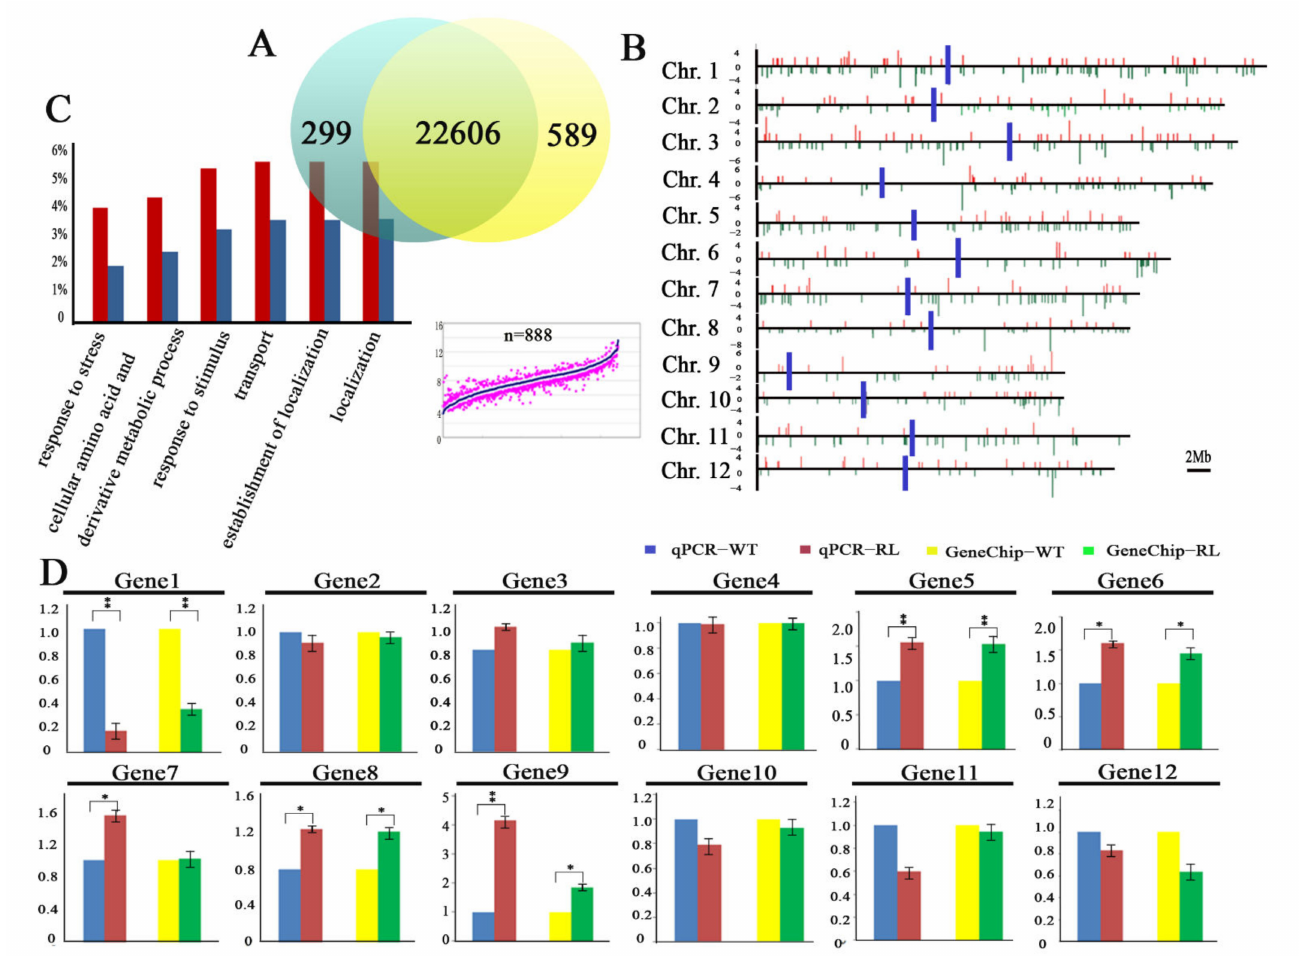
Figure 1. Genes expression variation between RL and its donor WT. ( A ) Microarray analysis iden- tified 888 differential expressed genes induced by tissue culture, including 299 upregulated and 589 downregulated genes, respectively. ( B ) The distribution of differentially expressed genes across rice genome. The red bars represent upregulated genes and the green bars downregulated genes. The blue bar represented centromere region. ( C ) Gene Ontology (GO) classification and enrichment analysis of the differentially expressed genes between RL and WT. ( D ) The expression of 12 genes was amplified by qRT-PCR for the verification of the microarray results. * p < 0.05, ** p <